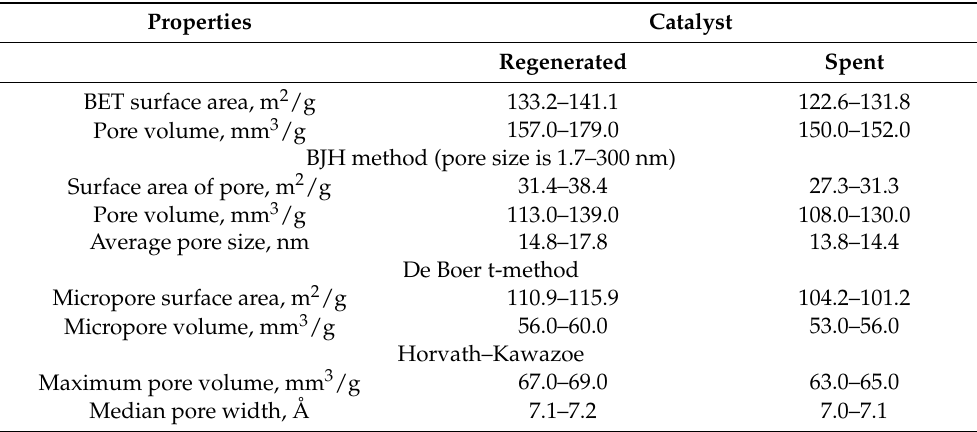
Table 2. Results of laboratory study of catalytic cracking catalysts.